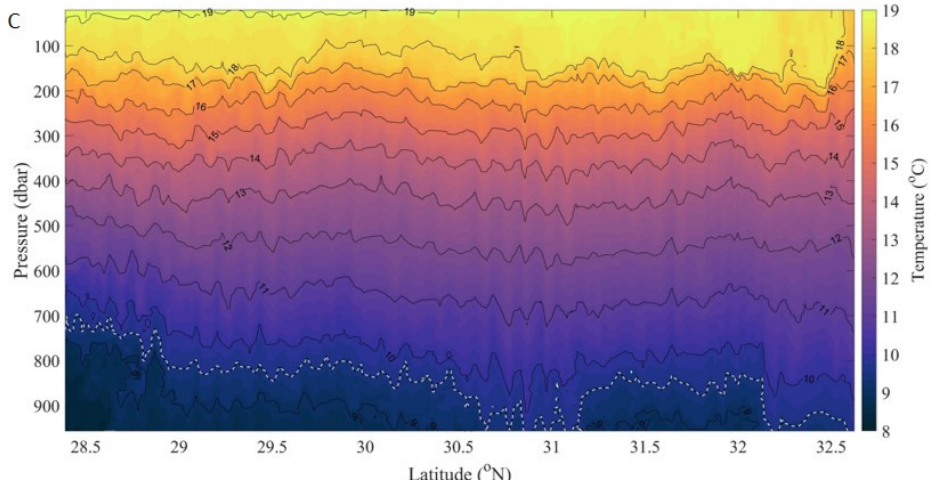
Figure 6. ( A ) Meridional salinity glider section. The dashed white contour represents the 35.5 iso- haline. ( B ) Meridional glider section of dissolved oxygen. The dashed white contour represents dissolved oxygen values of 140 µ mol kg − 1 . ( C ) Meridional glider section of temperature. The dashed white contour represents temperature values of 9.5 °C.